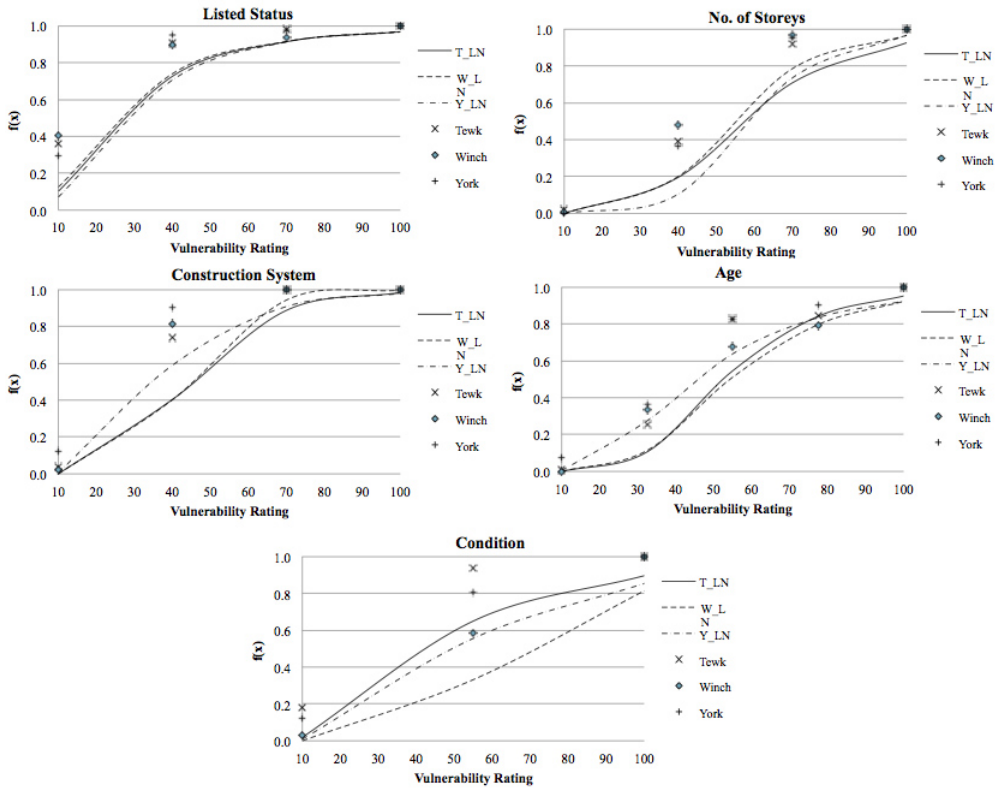
Fig. 5. Vulnerability descriptor log-normal and raw cumulative distribution for three sites: Tewkesbury, Winchester and York.